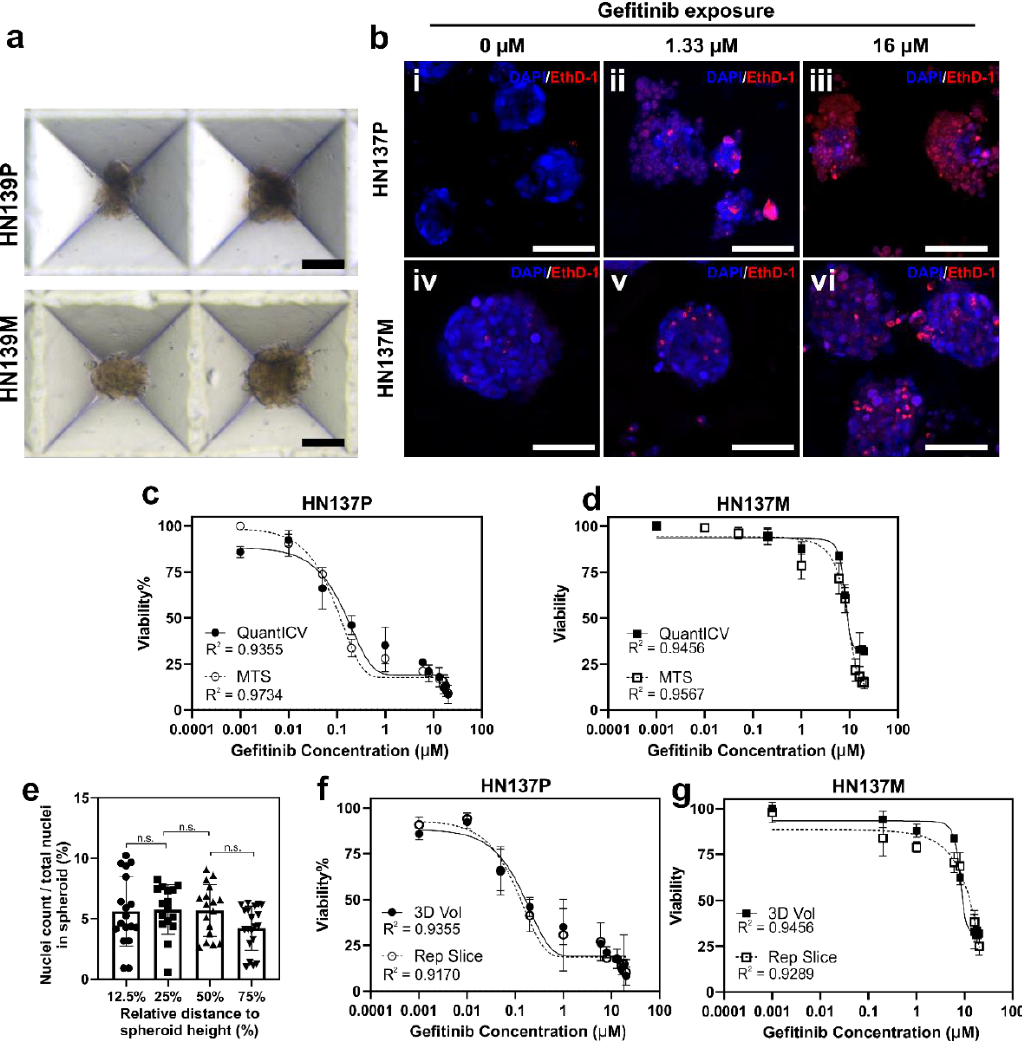
Figure 3. Validation of the QuantICV assay against the MTS assay in three-dimensional (3D) spheroid cultures of parental (HN137P) and metastatic (HN137M) OSCCs. ( a ) Brightfield images of parental OSCC (HN137P) and metastatic OSCC (HN137M) spheroids. Scalebar = 100 µm. ( b ) Confocal images showing double nuclear staining in (i–iii) parental (HN137P) and (iv–vi) metastatic (HN137M) OSCC spheroids exposed to different concentrations of Gefitinib. Scalebar = 100 µm. ( c , d ) Comparison of dose-responses to Gefitinib measured by MTS and QuantICV assays in ( c ) parental (HN137P) and ( d ) metastatic (HN137M) OSCCs. Data are averages of n = 3 repeats with ± standard deviation (SD). ( e ) Box plot showing cell nuclei distribution in 3D tumor spheroids at 12.5%, 25%, 50%, and 75% of spheroid depth. Uniform distribution of cell nuclei observed within 12.5–75% of the cell volume. p > 0.05. ( f , g ) Comparison of dose-responses to Gefitinib measured by enumerating dead and total cell nuclei in the entire 3D spheroid volume (3D Vol) or a single cross-sectional image slice (Rep Slice) in ( f ) parental (HN137P) and ( g ) metastatic (HN137M) OSCCs. Data are averages of n = 3 repeats with ± standard deviation (SD).